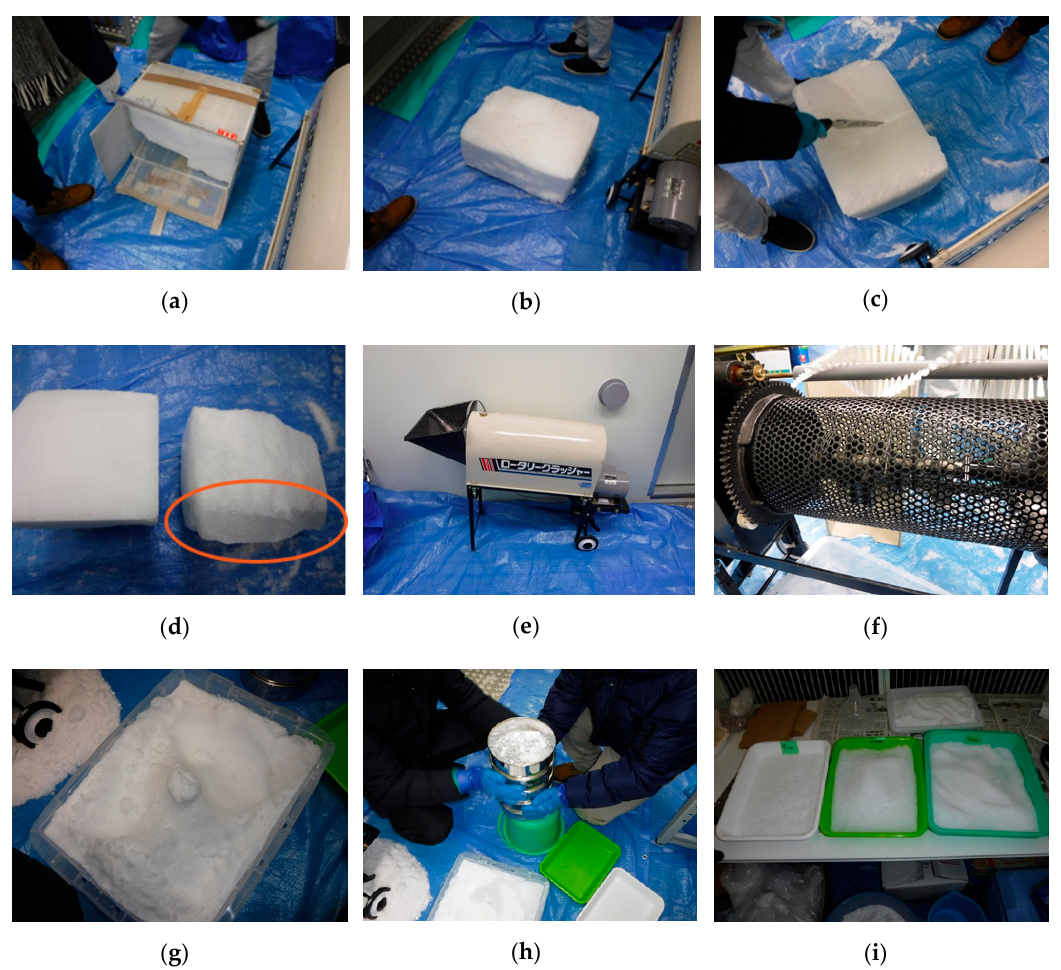
Figure 4. Photos of the procedure for creating snow particles: ( a ) taking the snow chunk from the box; ( b ) the snow chunk; ( c ) cutting the snow chunk into some pieces; ( d ) removing the ice conditions; ( e ) crushing snow with a crusher machine; ( f ) internal structure of the crusher machine with a 6 mm diameter mesh; ( g ) milled snow; ( h ) screening the milled snow; ( i ) classifying the snow according to its particle size (4 mm, 2 mm, or 1 mm).